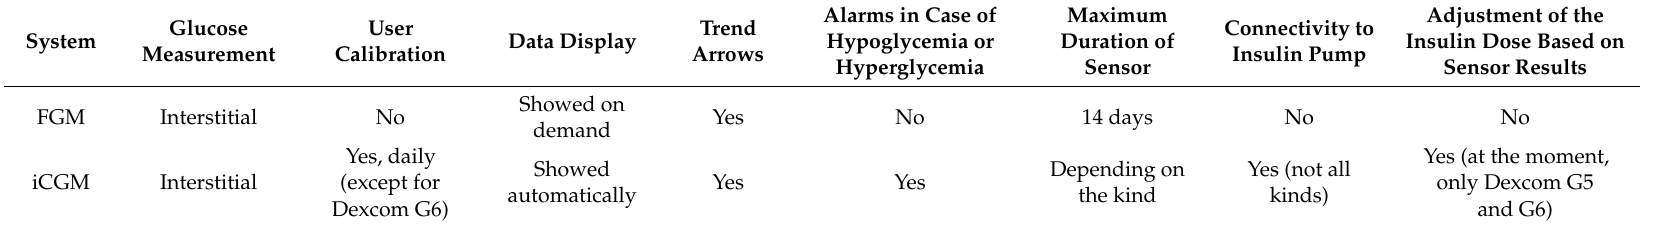
Table 1. Comparison between Continuous Glucose (iCGM) and Flash Glucose Monitoring (FGM)